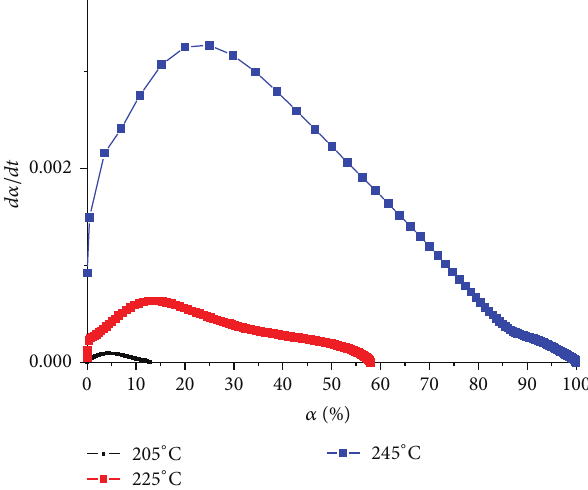
Figure 5: 𝑑𝛼/𝑑𝑡 versus conversion of BZ/F-51 hybrid networks in isothermal DSC.